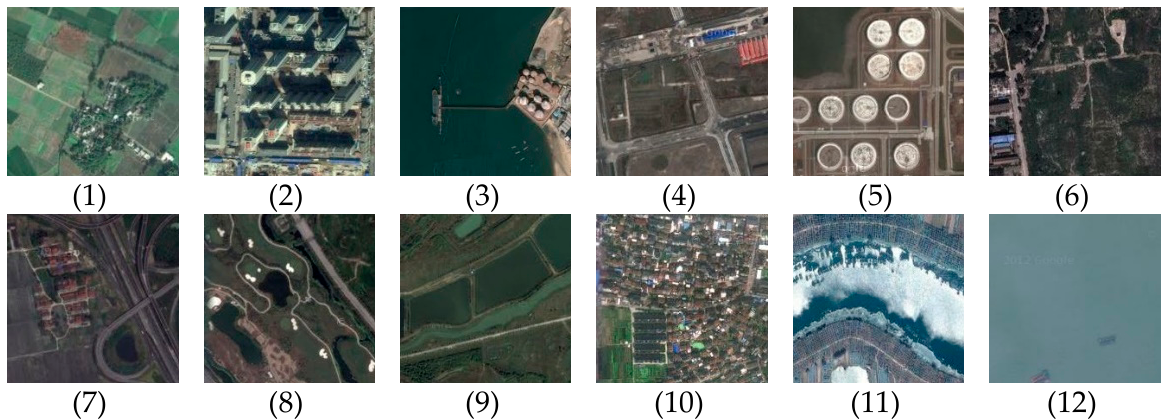
Figure 2. Examples from the SIRI-WHU dataset: (1) farmland, (2) business quarters, (3) ports, (4) idle land, (5) industrial areas, (6) grasslands, (7) overpasses, (8) parking lots, (9) ponds, (10) residential areas, (11) rivers, (12) water. The UC Merced (UCM) dataset is an aerial orthophoto shot from the national geologi- cal survey of the United States. It consists of 2100 remote sensing images from 21 scene classes, as shown in Figure 3, including agricultural, airplane, baseball diamond, beach, buildings, chaparral, dense residential, forest, freeway, golf course, harbor, intersection, medium-density residential, mobile home park, overpass, parking lot, river, runway, sparse residential, storage tanks, and tennis courts. Each class in the UCM dataset consists of 200 optical aerial images with 256 × 256 pixels and a 0.3-m